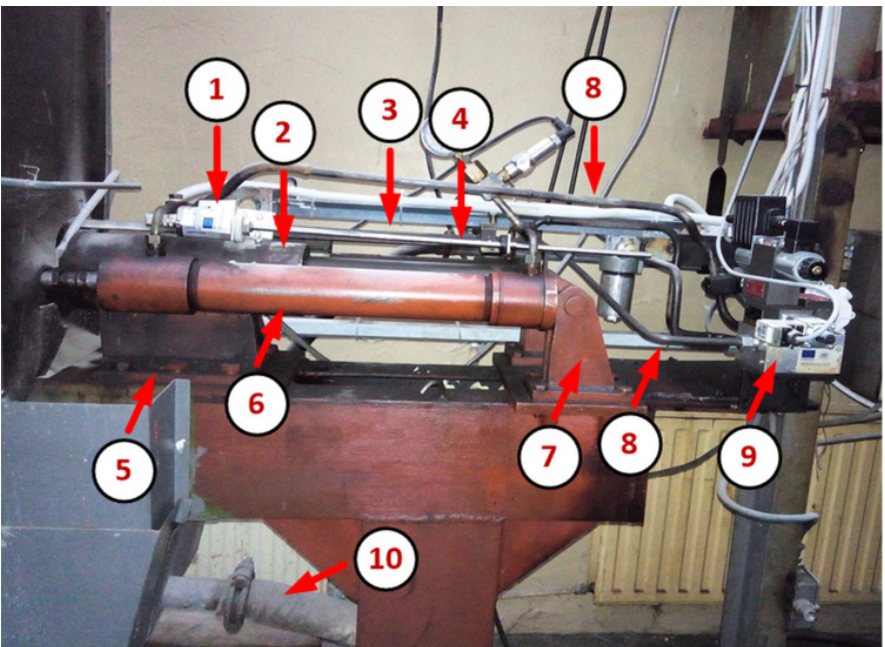
Figure 4. A more detailed description of the drilling rig parts: 1 —speed sensor of feed, 2 —ram slide, 3 —gear rod of speed sensor of feed, 4 —slide, 5 —prop of ram slide, 6 —double acting hydraulic cylinder, 7 —restraint of hydraulic cylinder, 8 —high-pressure tube, 9 — control system for the drive spindle,